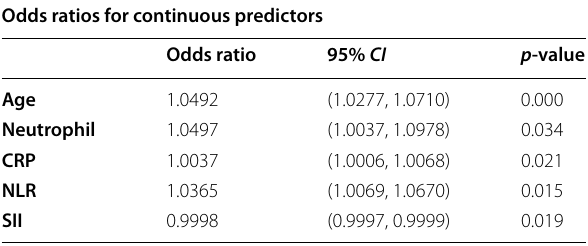
Table 3 Age, neutrophil, CRP, NLR, and SII, independent risk variables on death due to COVID-19, with OR